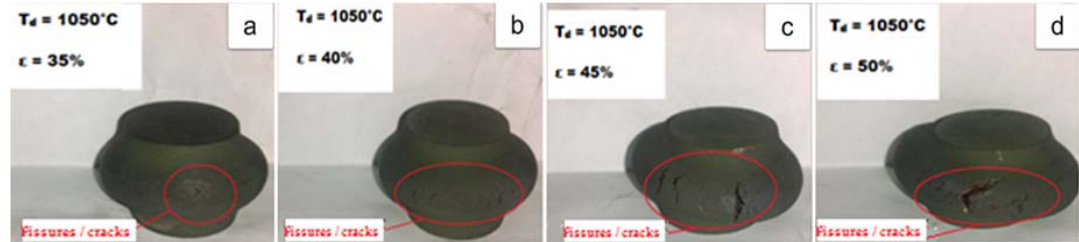
Figure 3. Samples with cracks on the lateral surface after upsetting: ( a ) T d = 1050°C, ε = 35%; (b ) T d = ( b ) T d = 1050 ◦ C, ε = 40%; ( c ) Td = 1050 ◦ C, ε = 45%; and, ( d ) T d = 1050 ◦ C, ε = 1050 °C, ε = 40%; ( c ) Td = 1050 °C, ε = 45%; and, ( d ) T d = 1050 °C, ε = 50%.